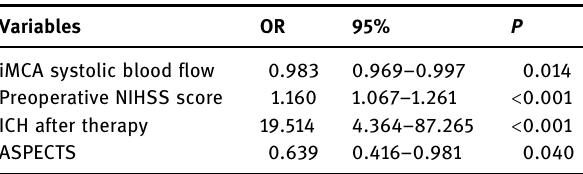
Table 3: Multivariable analysis of the factors associated with a good